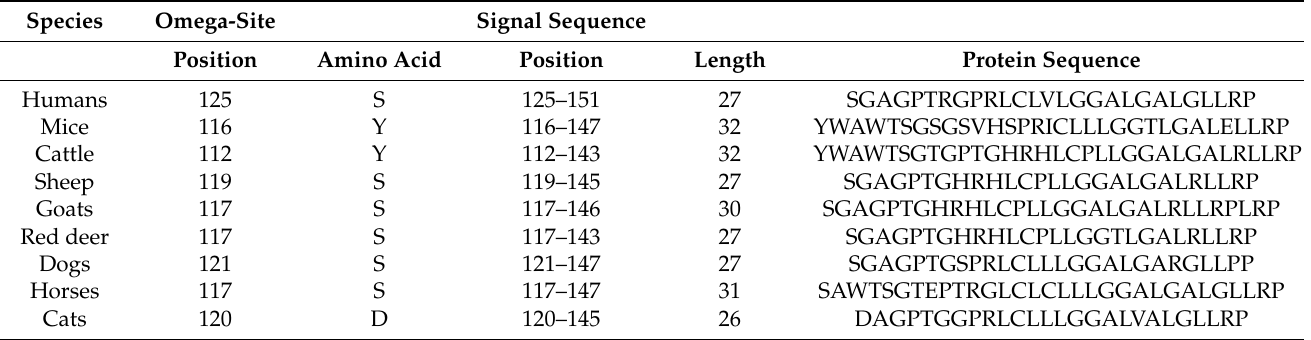
Table 5. Prediction of the omega-site and signal sequences of the glycosylphosphatidylinositol (GPI)-anchor of the Sho protein by